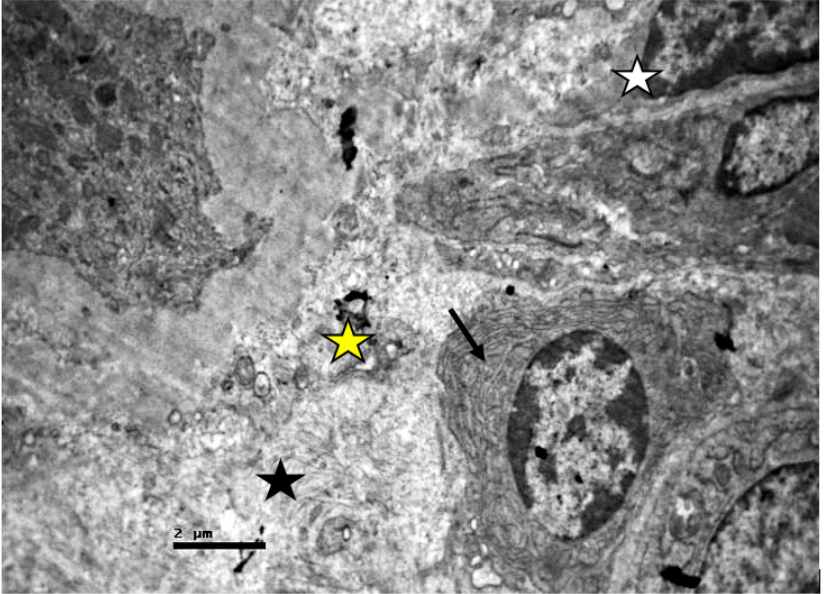
Figure 16. Connective tissue of no-resuscitated swine sample that shows apoptotic material (yellow star) and extensive edema (black star) and expanded capillary (white star), and active fibroblasts (black arrow).